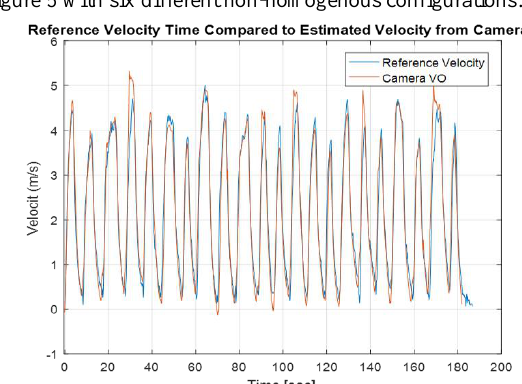
Figure 4. Velocity estimated from the camera using optical flow compared against reference velocity.